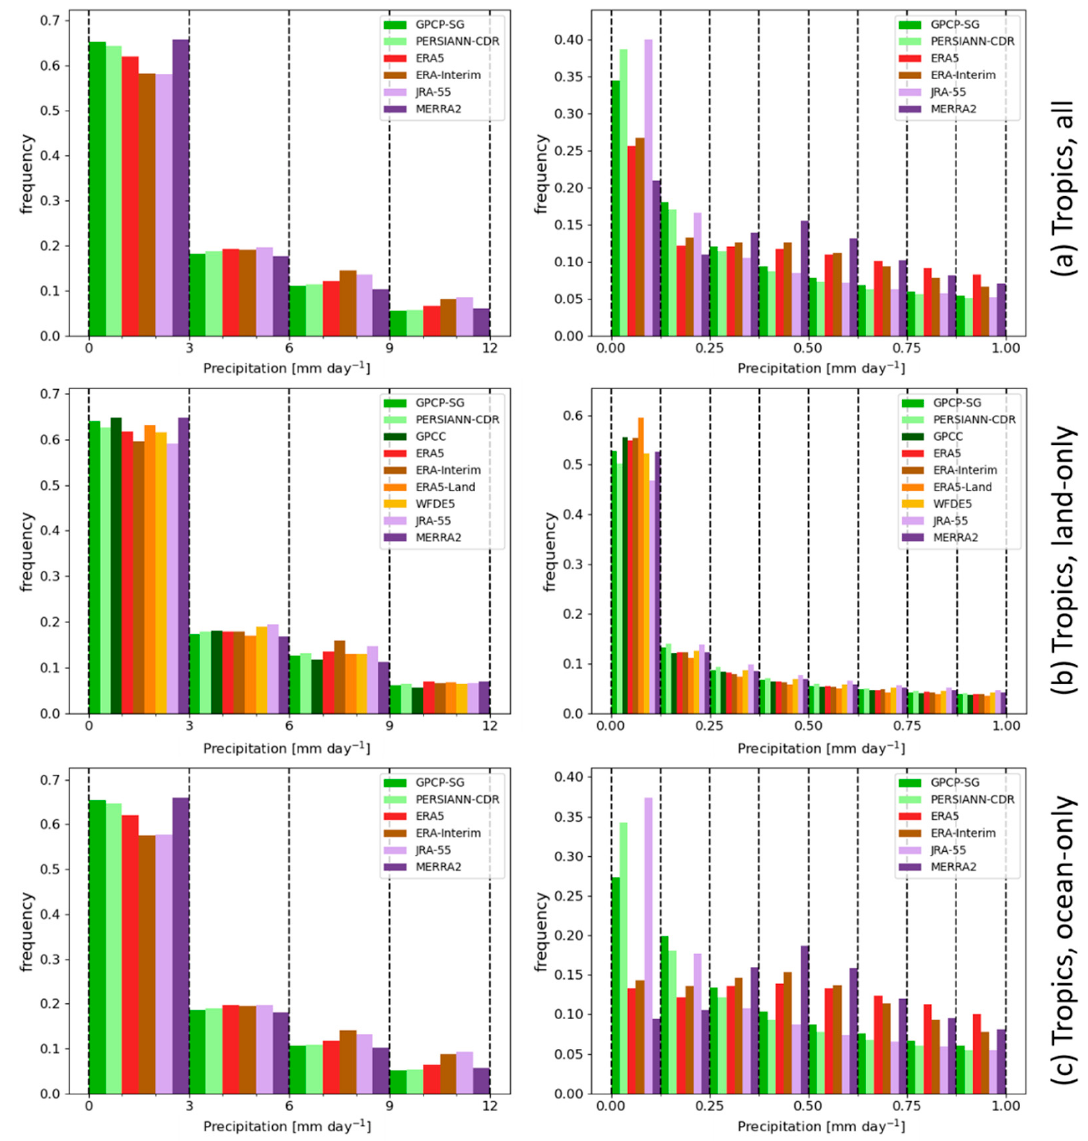
Figure 4. Histograms of precipitation rates in the Tropics (30° S–30° N) with no values masked ( a ), ocean values ( b ) or land values masked ( c ), for the 0–12 mm day − 1 range (left column) and 0–1 mm day − 1 range (right column). Histograms were calculated using monthly values in the period 1983–2016. ERA5-Land, GPCC, and WFDE5 are available over land only.